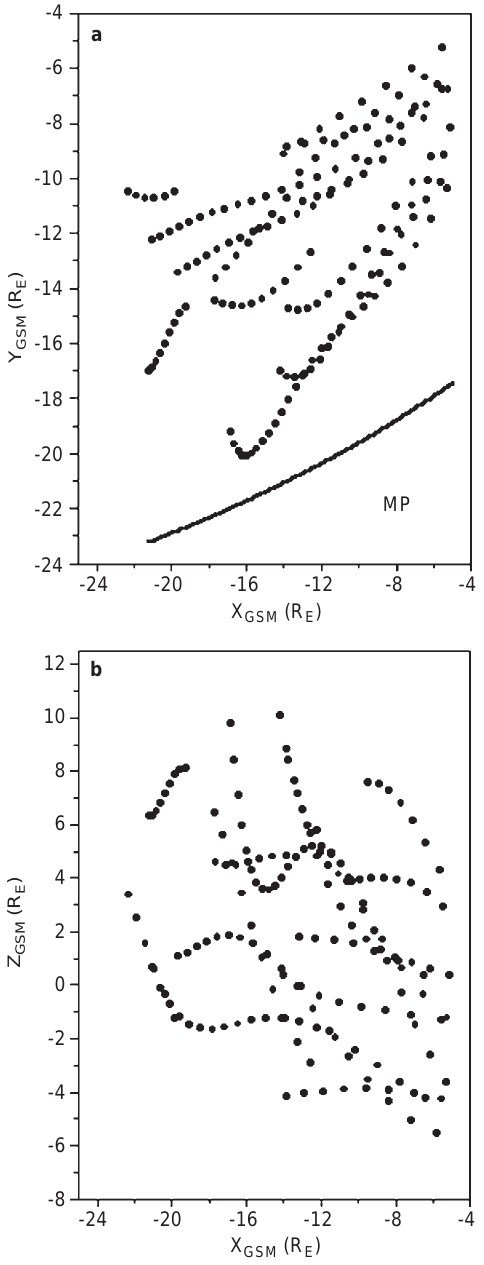
Fig. 1a, b. Probe positions in the dawn flank of the magnetosphere in selected time intervals: a projection into XY plane (model magneto- pause (Sibeck et al. , 1991) is shown); b projection into